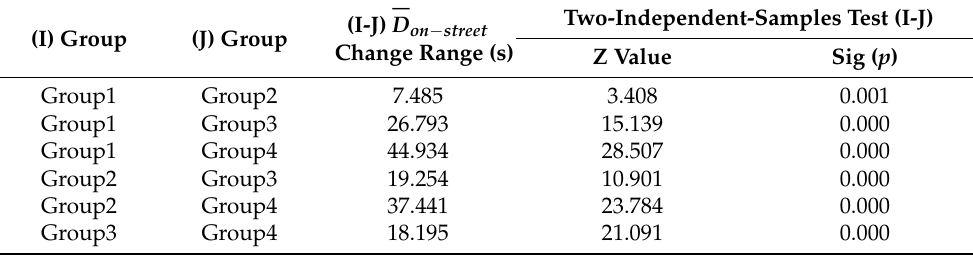
Table 7. Two-independent-samples test (I-J) of the D on − street of road traffic